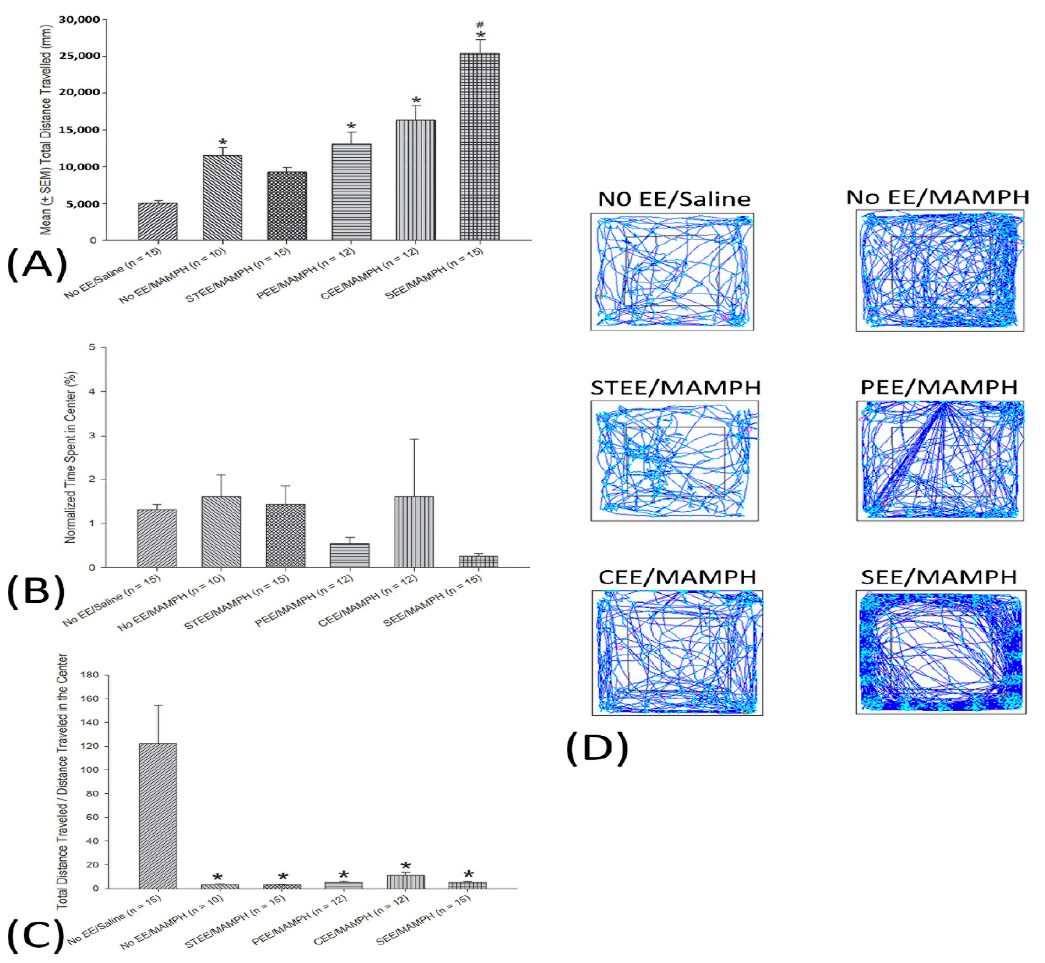
Figure 1. Various environmental enrichment (EE) housing conditions had differential effects on methamphetamine (MAMPH)-induced behavioral sensitization as assessed by: ( A ) total distance traveled (in mm), ( B ) normalized time spent in center (%), and ( C ) total distance traveled/distance traveled in the center. Mice reared under standard housing (No EE) or various EE conditions were intraperitoneally injected with 1 mg/kg of MAMPH or normal saline. No EE/Saline ( n = 15), No EE/MAMPH ( n = 10), standard EE (STEE)/MAMPH ( n = 15), physical EE (PEE)/MAMPH ( n = 12), cognitive EE (CEE)/MAMPH ( n = 12), and social EE (SEE)/MAMPH ( n = 15). ( D ) Path tracing for the No EE/Saline ( n = 15), No EE/MAMPH ( n = 10), STEE/MAMPH ( n = 15), PEE/MAMPH ( n = 12), CEE/MAMPH ( n = 12), and SEE/MAMPH ( n = 15) groups. * p < 0.05 compared with the No EE/Saline group, and # p < 0.05 compared with the No EE/MAMPH group. Path tracing results indicated an increase in the time spent in the center of the open- field apparatus for the No EE/MAMPH, STEE/MAMPH, PEE/MAMPH, CEE/MAMPH,